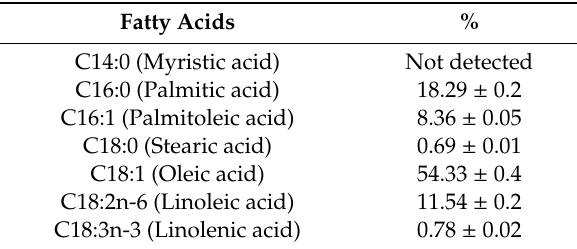
Table 5. Fatty acid profile of avocado oil.